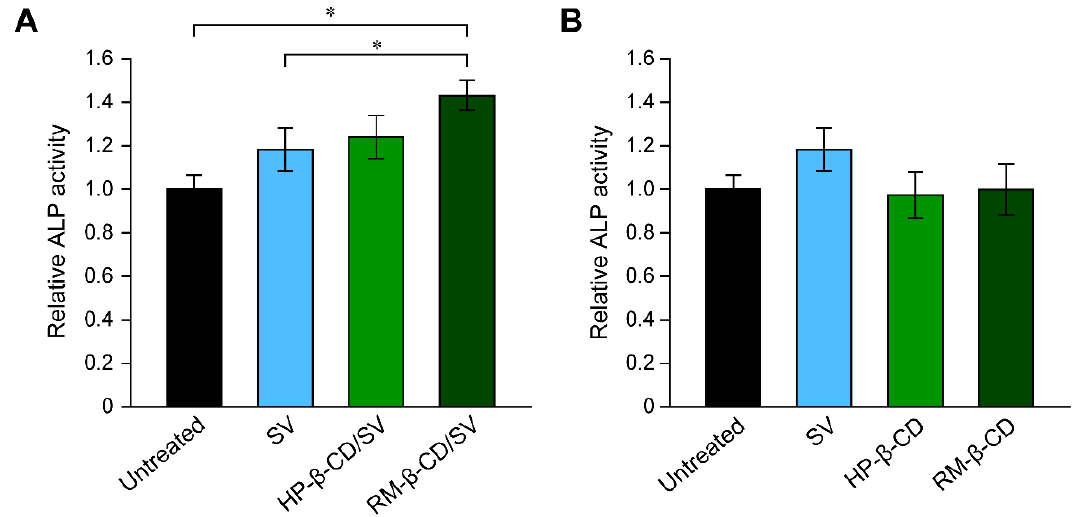
Figure 3. ( A ) Relative ALP activity in MC3T3-E1 cells after treatment with free SV (100 nM), HP-β-CD/SV inclusion complexes (SV: 100 nM, HP-β-CD: 1 μM), and RM-β-CD/SV inclusion complexes (SV: 100 nM, RM-β-CD: 1 μM) for 14 days. ( B ) Relative ALP activity in MC3T3-E1 cells after treatment with free SV (100 nM), HP-β-CD (1 μM), and RM-β-CD (1 μM) for 14 days. Data are expressed as the mean ± S.D. ( n = 3, * p < 0.05). Reproduced with permission from [74] © 2016 Elsevier.